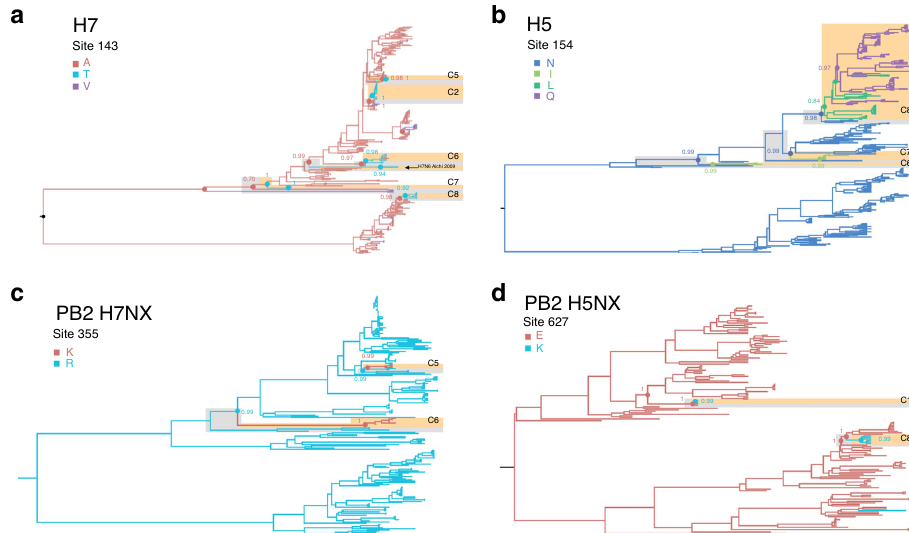
Fig. 3 Reconstruction of amino acid evolution at selected HAPMs. Maximum clade credibility (MCC) trees showing the reconstruction of ancestral states for four illustrative HAPMs ( a − d ). Branches are coloured according to the inferred ancestral amino acid states (tip states not shown). Nodes representing the immediate LP ancestors and nodes from which the HP clusters directly descend are shown with circles. The posterior probabilities for a given amino acid state occurring at the speci fi ed node are indicated. The HP sequences (HP clusters) are highlighted in orange, whilst the immediate ancestral LP sequences are highlighted in grey. For details on sampling date, location, and host species, see Supplementary Figs. 5 –